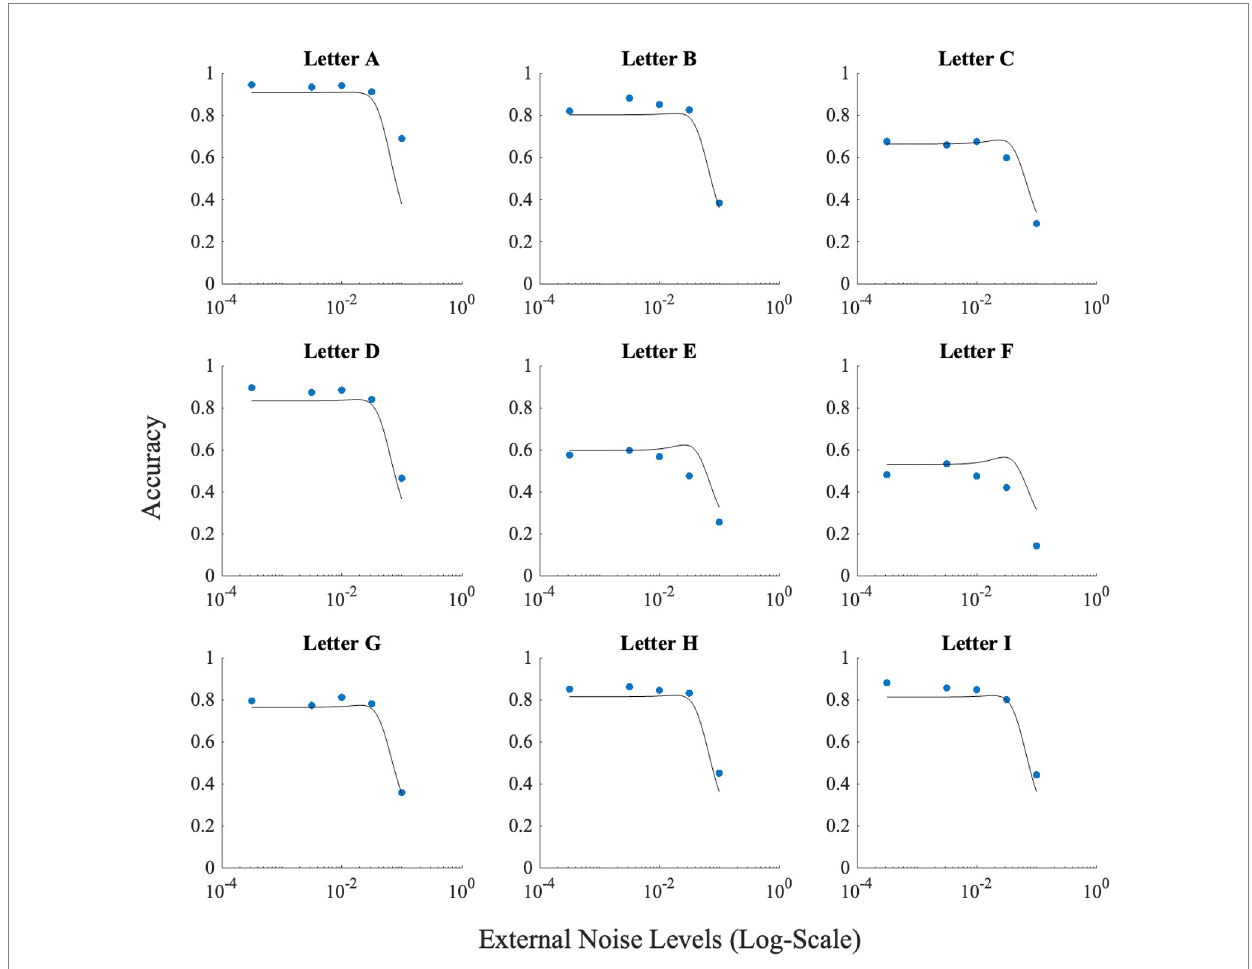
FIGURE 12 Figure illustrating the effect of noise on each letter used for Experiment 2. Horizontal axis ( x -axis) represents noise levels in log-scale, and the vertical axis ( y -axis) shows accuracy. Accuracy at zero external noise was plotted at a level of 3 × 10 − 4 of external noise. Lines show the fit of the model (Model 1) to this